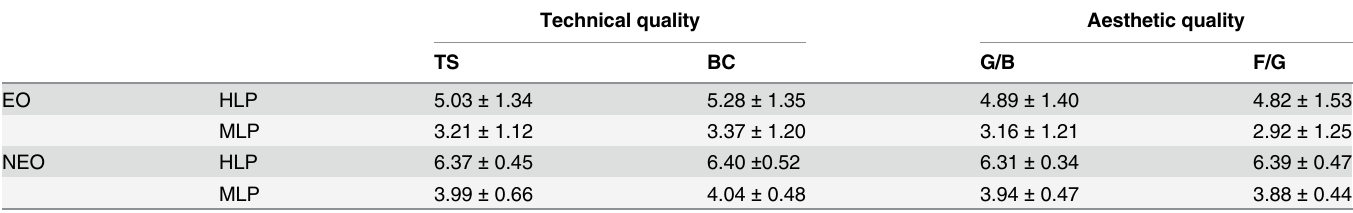
\eta P2 = 0.905 and for the 2 Movement Qualities: (technical and aesthetic): F = 18.39, p < (1, 162) 0.001, \eta P2 = 0.254. The high-level performance received a higher evaluation compared to the middle-level performance and the two qualities of the movement observed were evaluated dif- ferently. Importantly, the interaction between the 2 levels of Performance x the 2 Groups of Ob- servers, and the interaction between the 2 Movement Qualities x the 2 Groups of Observers = 8.94, p < 0.010, \eta P2 = 0.142 and F = 6.52, p < were significant (respectively F (1, 54) (1, 54) 0.050, \eta P2 = 0.108). The post hoc comparisons for the former interaction indicated that the level of the Performance was clearly distinguished by both groups ( p < 0.001) (see Table 3